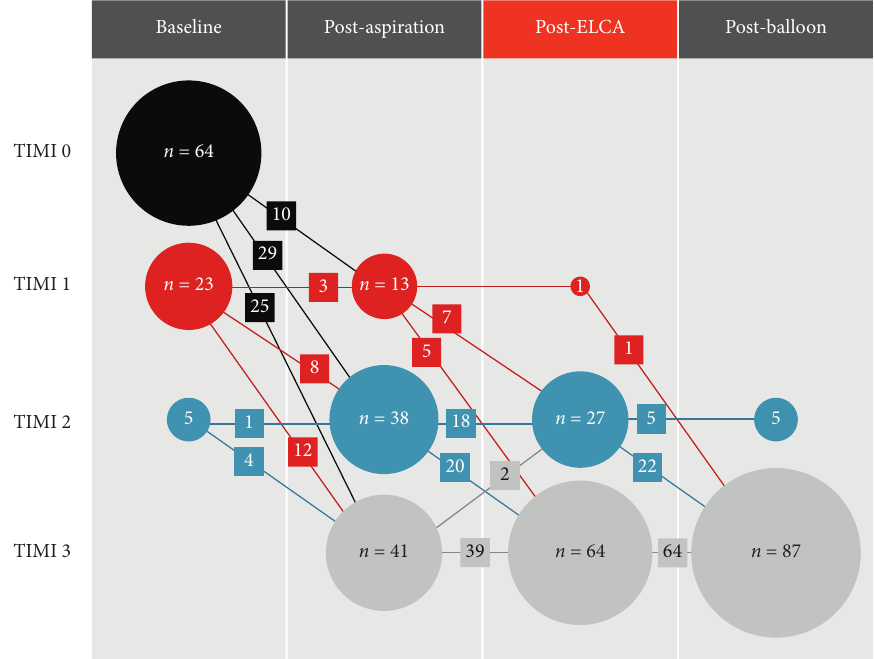
Figure 2: TIMI flow grade and the number of the patients after each of the procedures. TIMI, thrombolysis in myocardial